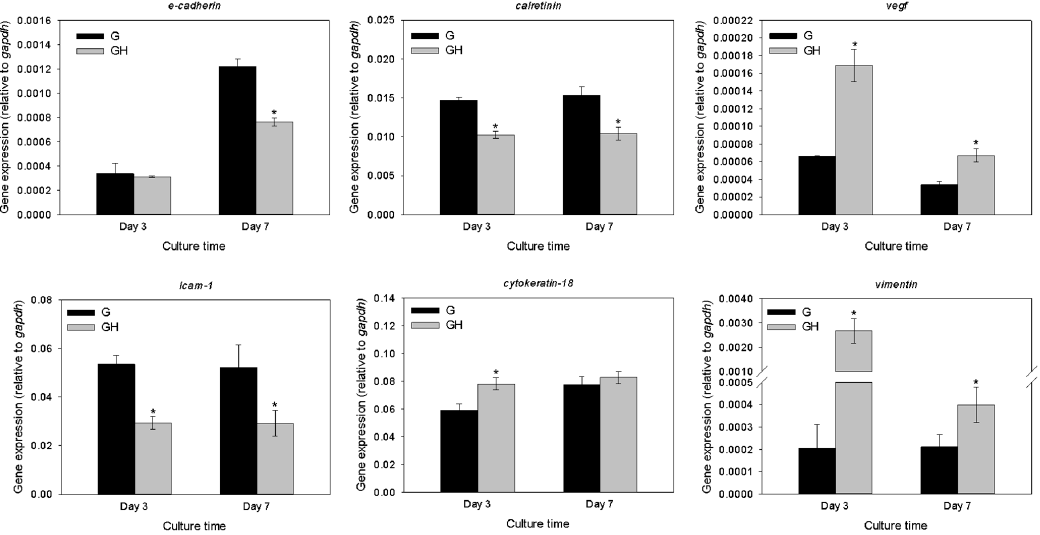
Figure 6. Gene expression of the mesothelial cells cultured in G and GH from a quantitative real-time polymerase chain reaction (qRT-PCR). * p < 0.05 compared with G.